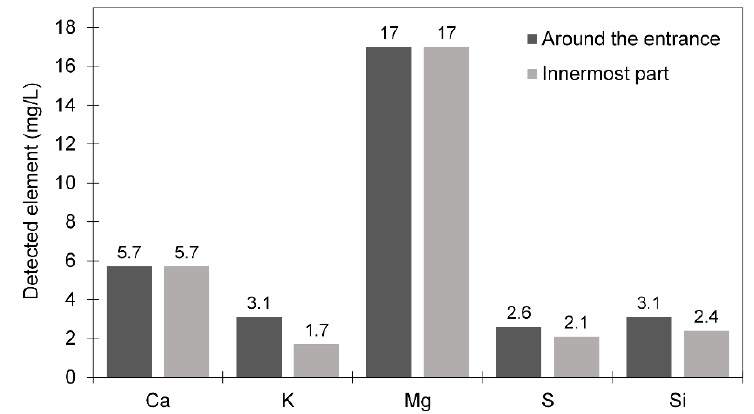
Figure 3. Element distribution in the spring water from the cave wall.